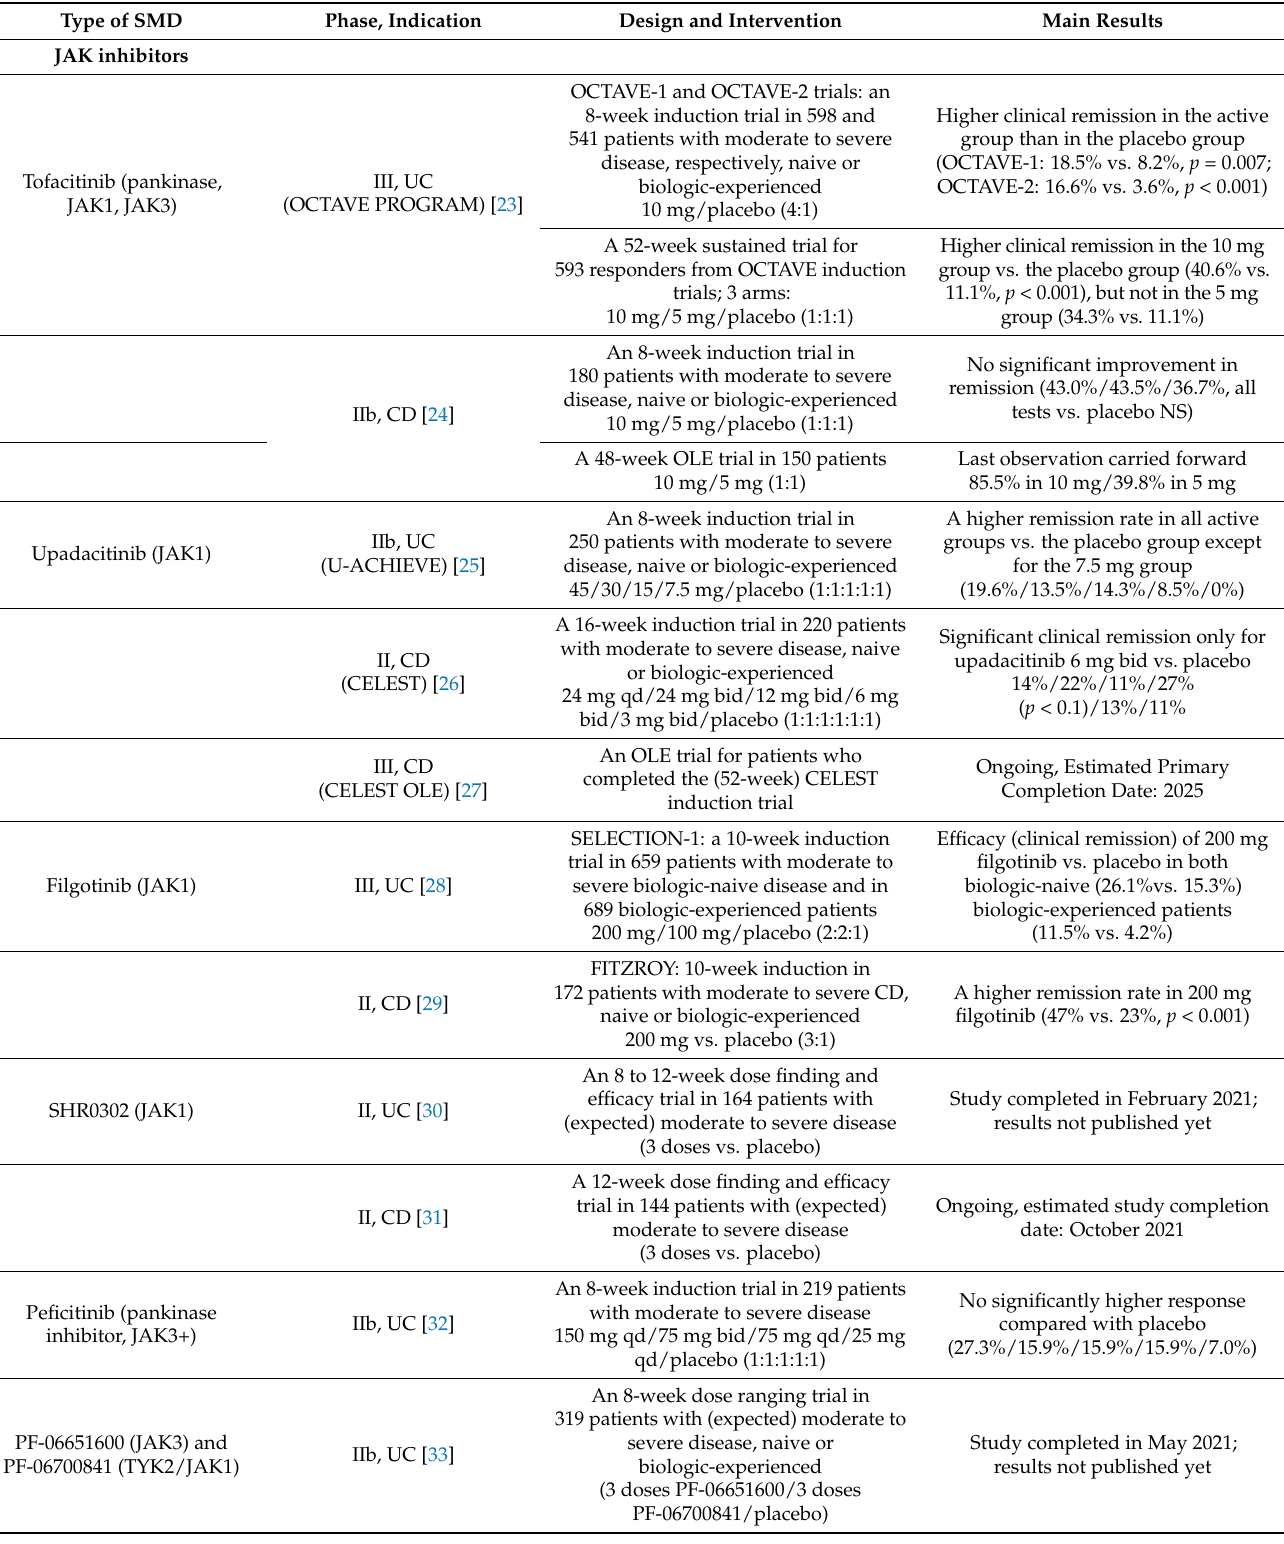
Table 1. Main published and ongoing clinical trials with Small Molecules Drugs (SMDs) in inflammatory bowel disease. Type of